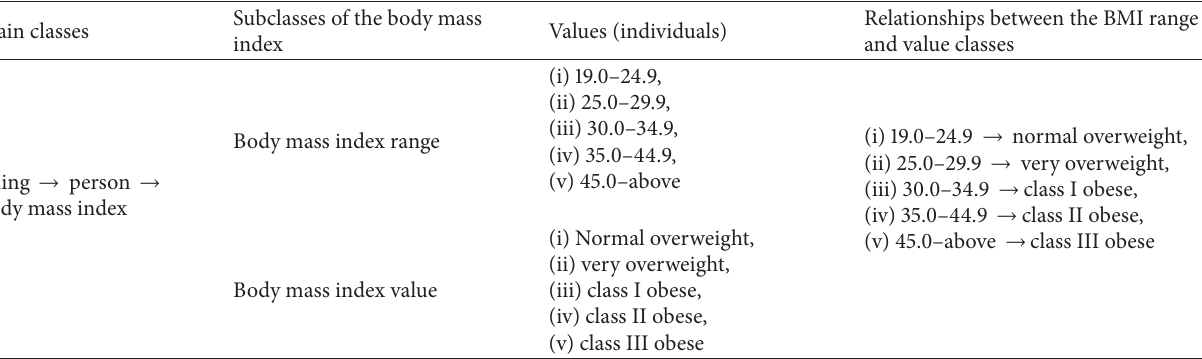
Table 5: Body mass index class includes two subclasses: body mass index range and body mass index value, with their values for